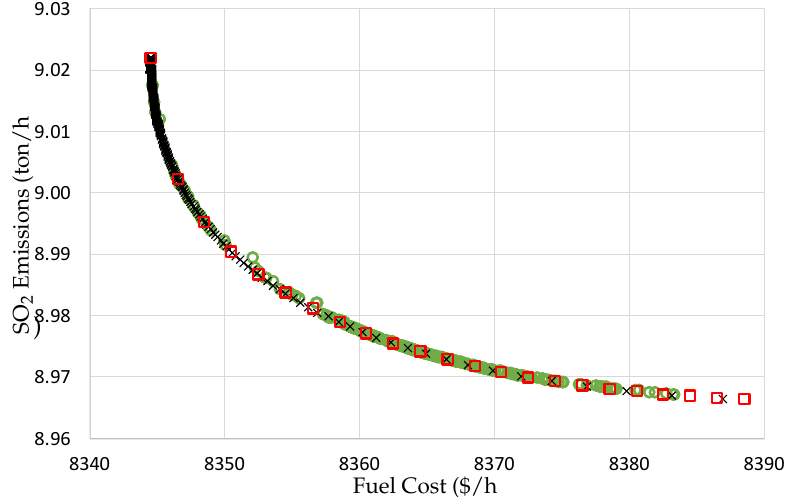
Figure 7. Pareto front for fuel cost and SO 2 emissions constructed using 500 elements. Red squares represent SQP, green circles represent NSGA-II , and black × represent